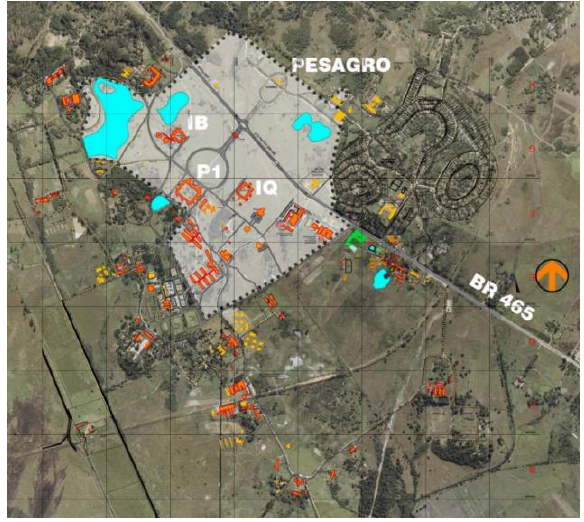
Figure 01 . Protected area. Source: adapted by INEPAC’s process number E-13/001.540/98, fl.